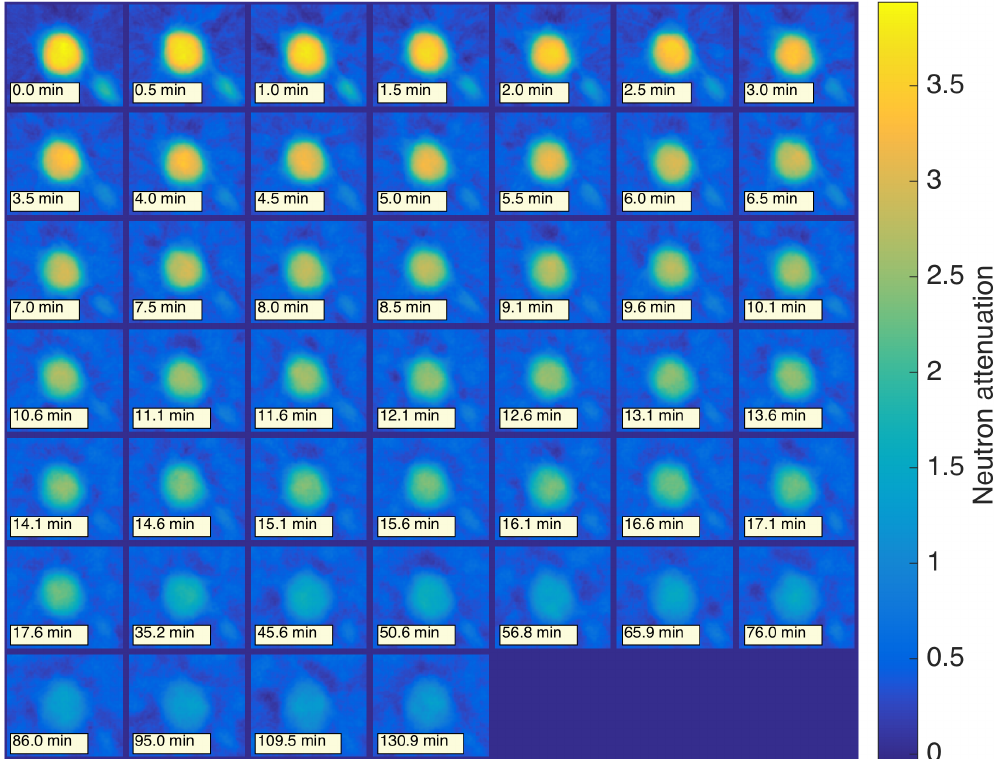
Figure 5. Time series neutron tomography of D 2 O transport into the root of a 2-week old lupine (nighttime). These images show the change in neutron attenuation across the root tissue at different times after D 2 O injection (time is indicated in minutes). As D 2 O enters the root tissue, D 2 O:H 2 O increases and neutron attenuation decreases. D 2 O:H 2 O is indicated by low attenuation (blue); low D 2 O:H 2 O is indicated by high attenuation (yellow). The images show a 5 × 5mm region of one horizontal slice through the 3-D data at a depth of 50mm from soil